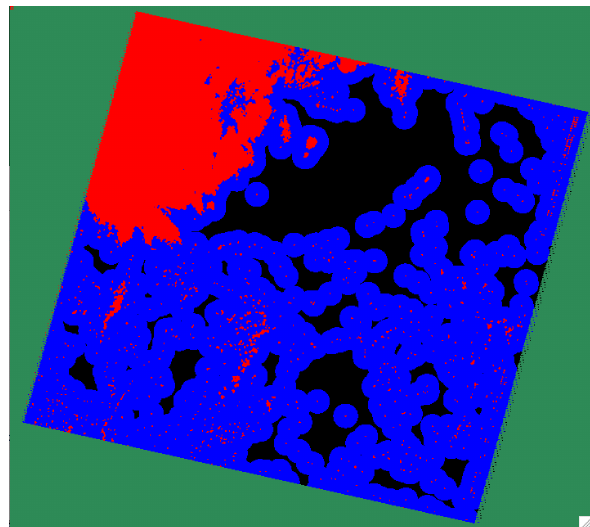
standard deviations would be consistent for all images based on the validation dataset, but the scene percentage is unique to this example.